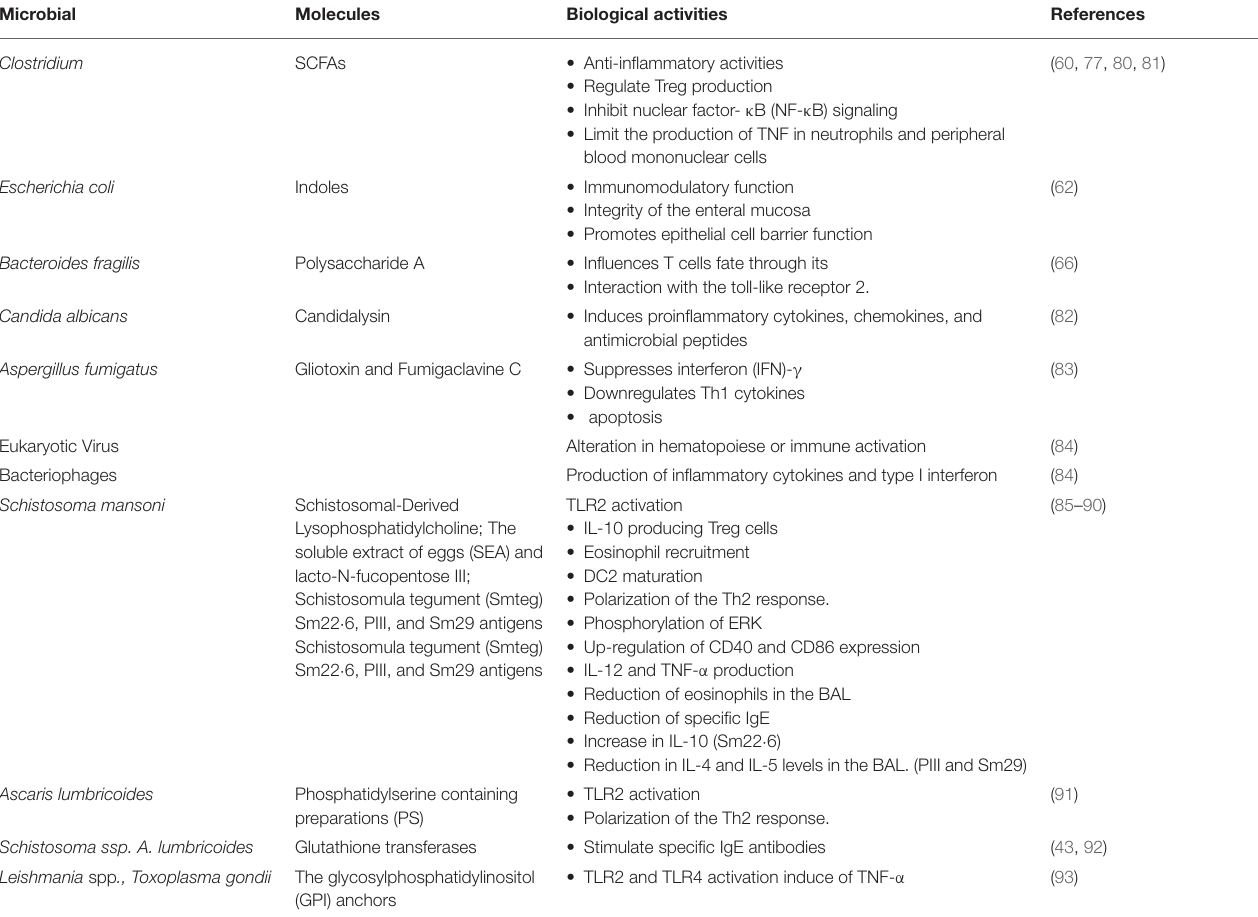
TABLE 1 | Summary of the main products (molecules) from holobionts with immunomodulatory potential and biological activities in the